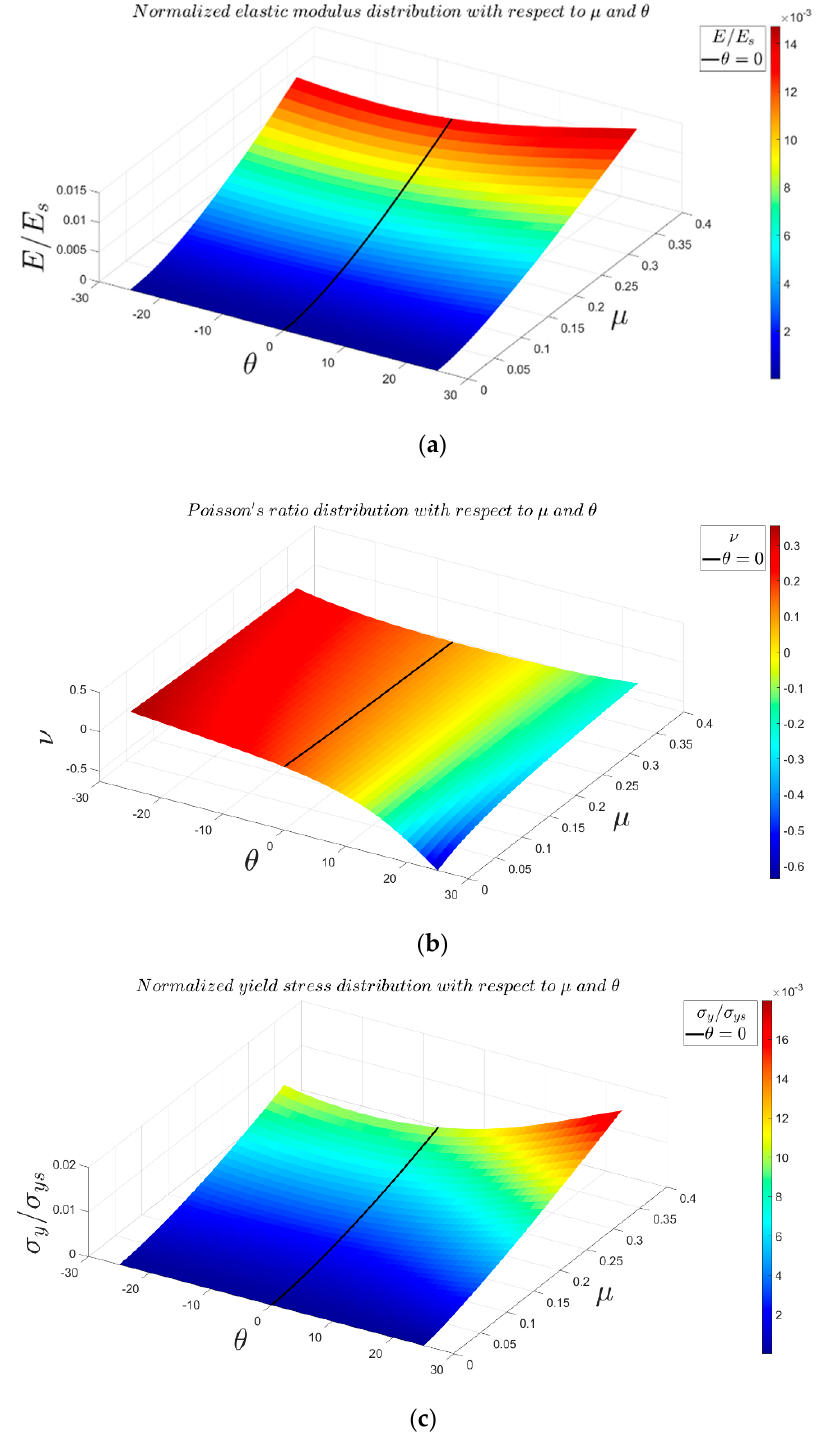
Figure 16. Variations of mechanical properties of lightened structure with respect to 𝜃 and 𝜇 : ( a ) elastic modulus, ( b ) Poisson’s ratio, and ( c ) yield stress. The specific case of 𝜽 = 0 is shown as a solid line.